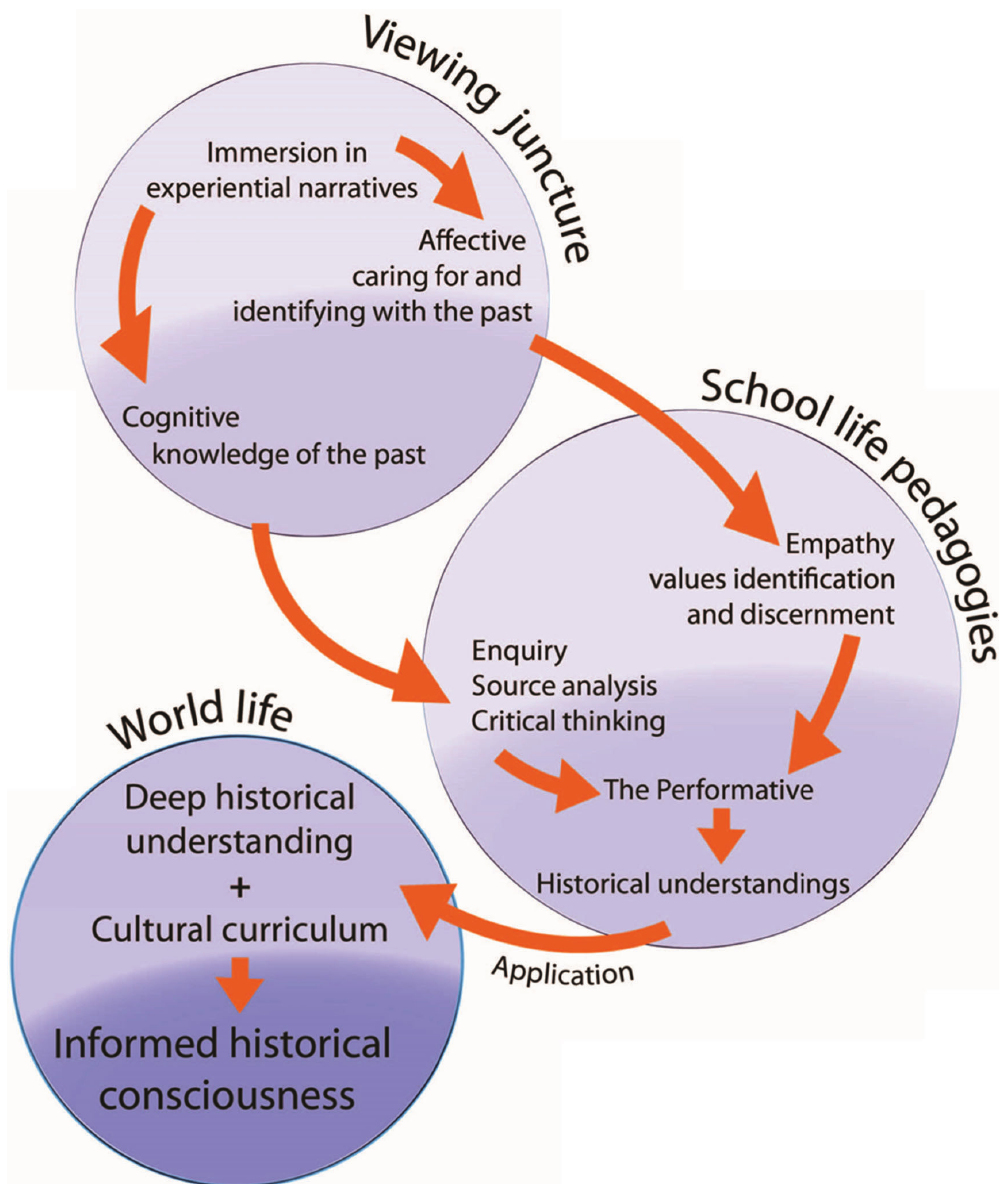
Figure 1: The role of historical film in history education and historical